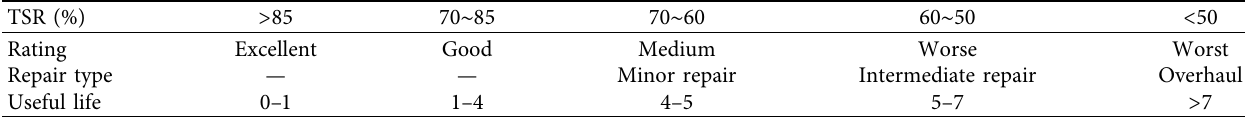
Table 5: Classification of the PAC water stability grade.